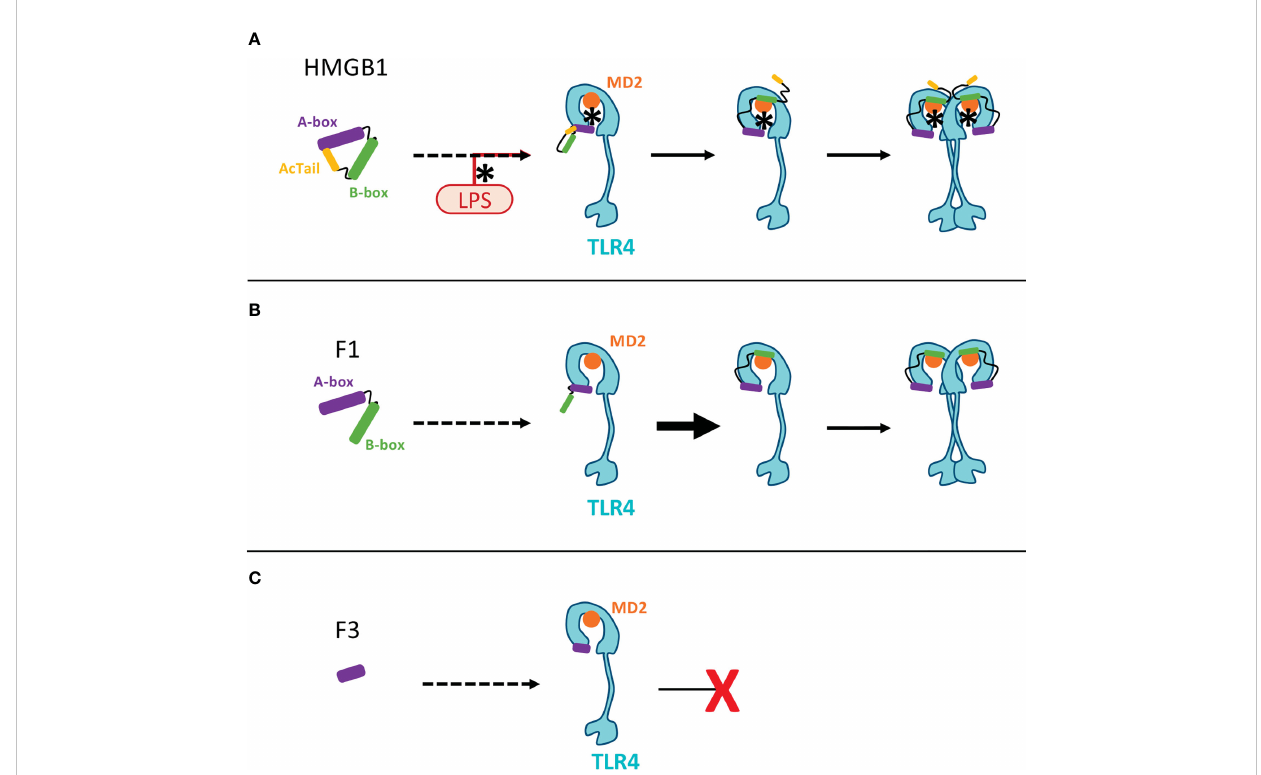
FIGURE 11 Molecular hypotheses associated to HMGB1 binding toTLR4-MD2 and the inhibiting action of the F3 fragment. This scheme aims to illustrate previous working hypotheses published by others on the opposite effects of the A- and B-box fragments on TLR4-mediated signaling (28).